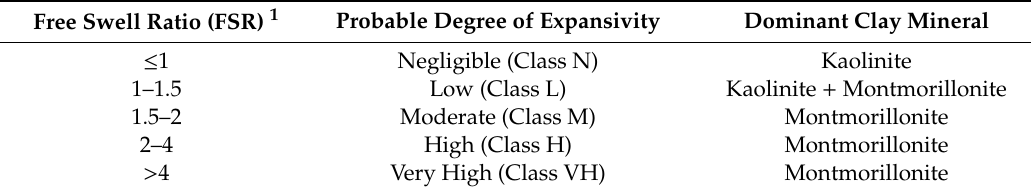
Table A2. Classification procedure for identifying clay mineralogy based on the FSR